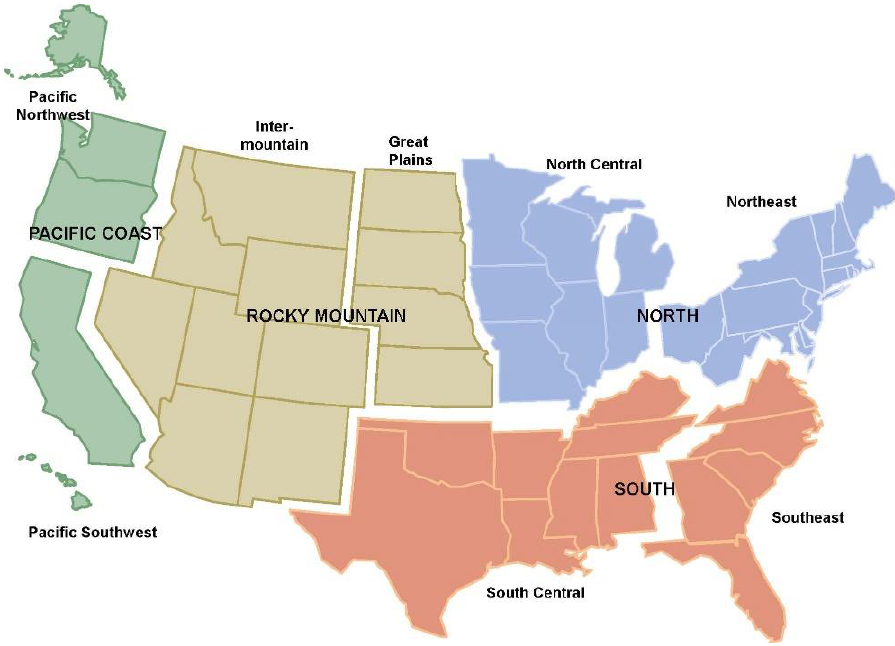
Figure 2. United States Resources Planning Act regions represented in FOROM.